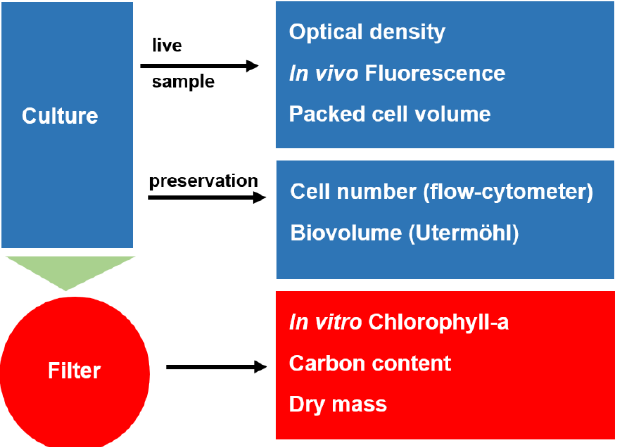
Figure 1. Sample treatment for estimation of microalgal